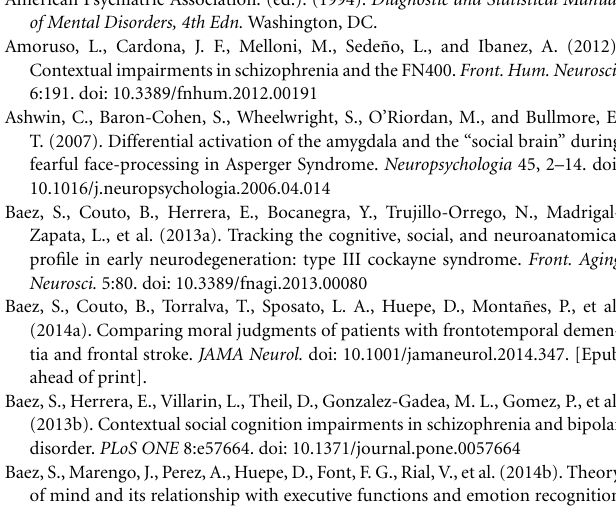
processing depends on a fronto-insular-temporal network which: (1) updates contextual cues and uses them to make predictions (frontal areas); (2) coordinates the internal (body) and exter- nal (insula) milieus; and (3) consolidates context-social target associative learning (temporal regions). Initially, this model was proposed as an approach to understand social cognition impair- ments in the behavioral variant of frontotemporal dementia (bvFTD), a neuropsychiatric disease characterized by a